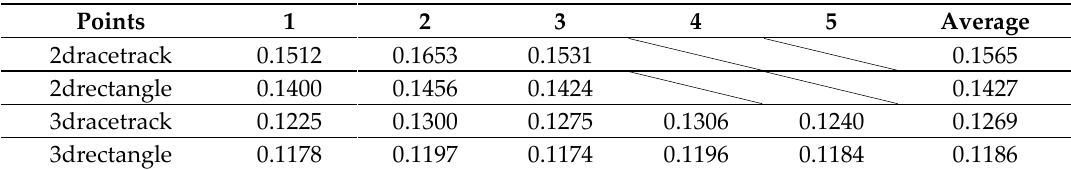
Table 3. 3 Coupling coe ffi cients at di ff erent points. Energies 2019 , 12 , x FOR PEER REVIEW